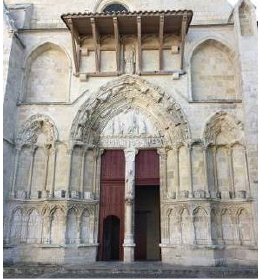
Figure 2. The portal of the Collegiate church in Saint Emilion.